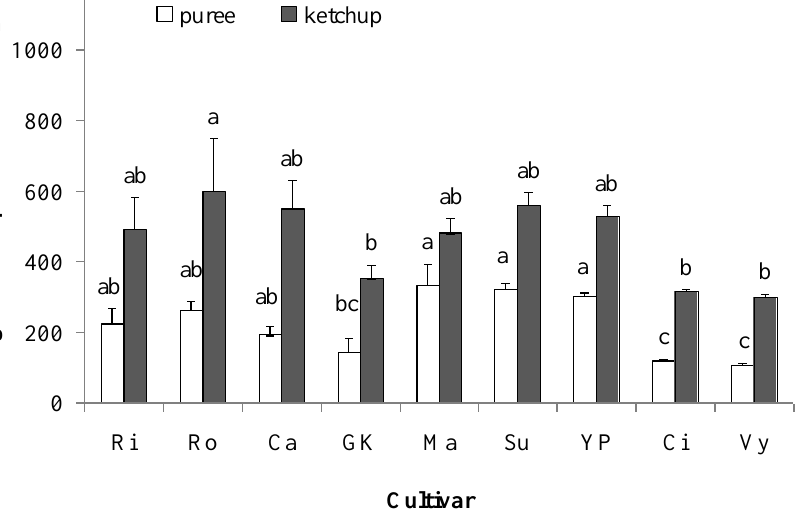
Figure 4. Relative changes in the content of total phenolic compounds of tomato cultivars depending on processing method: puree and ketchup (Ri—‘Rilia’, Ro—‘Roma’, Ca—‘Campbell-28’, GK—‘Goldene Königin’, Ma—‘Marmande’, Su—‘Suso’ F1, YP—‘Yellow Pearshaped’, Ci—‘CIMA’, Vy—‘Vyta’). The changes were calculated based on data presented in Table 1. The relative change in the lycopene content of the fresh tomato fruit is 0 by definition. Different letters indicate significant differences within each processing method for cultivars by Duncan test at p ≤ 0.05, n = 16.